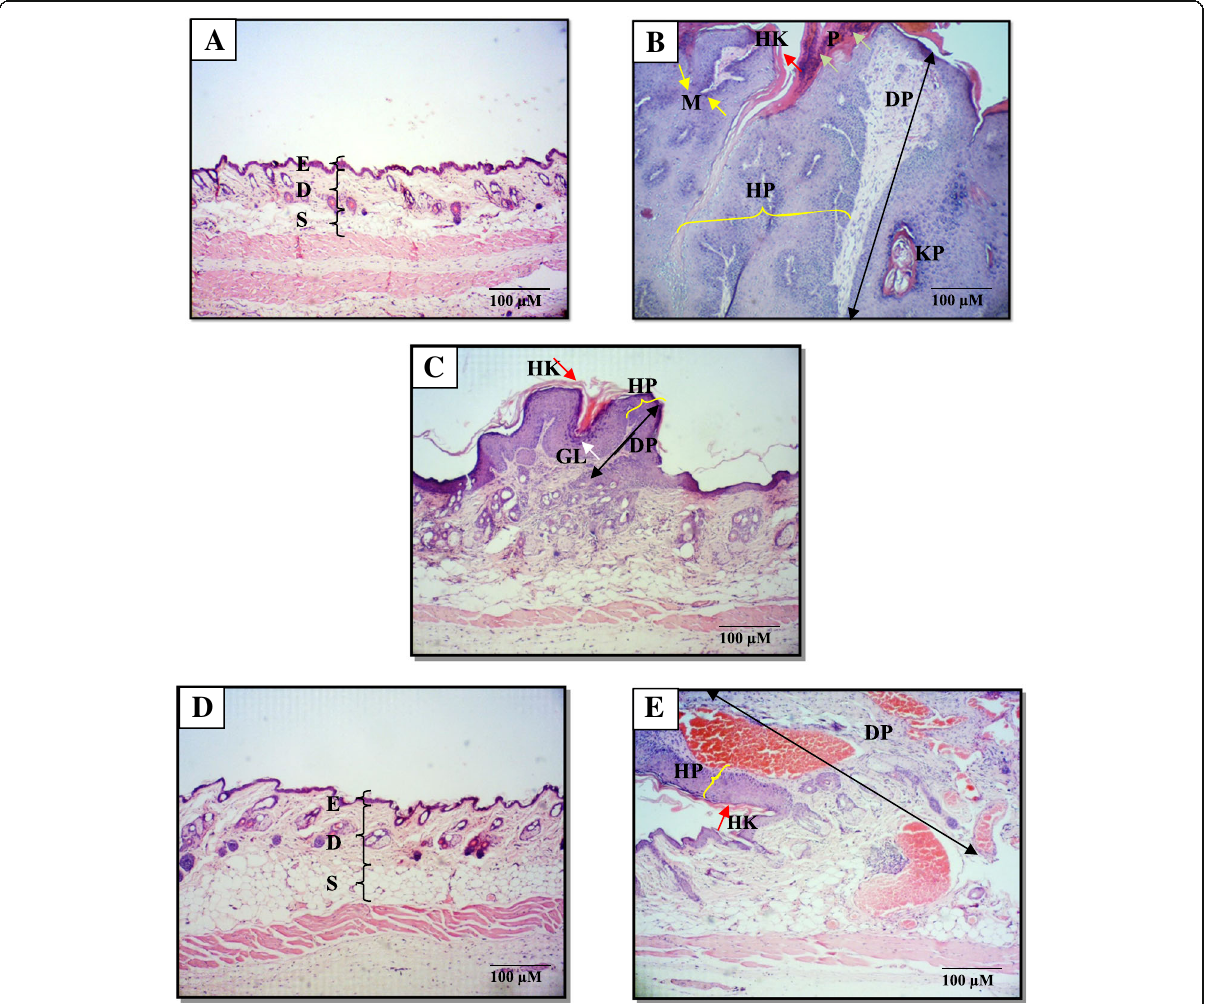
Fig. 1 Micrographs of H&E skin tissues sections treated with ( a ) acetone (Group I; vehicle control) showed normal skin thickness. ( b ) DMBA/TPA (Group II; carcinogen control) showed huge hyperplastic epidermal layer, with increased number of keratinocyte (hyperkeratosis) and parakeratosis, increased size with huge extension of the dermal papillae, presence of keratin pearls and mark mitotic activity. ( c ) 85 nM annonacin (Group III; treatment) showed mild hyperplastic epidermal layer, mild dermal papillae extension, mild hyperkeratosis and prominent granular layer. ( d ) 85 nM annonacin without DMBA/TPA induction (Group IV; treatment control) showed the closest resemblance of skin thickness and morphology to Group 1. ( e ) 10 mg/kg curcumin (Group V; reference) showed moderate hyperplastic epidermal layer with increased number of keratinocyte, increased size with huge extension of dermal papillae. Note: [hyperplastic epidermal layer (HP) marked with yellow curly bracket], [hyperkeratosis (HK) marked with red arrow], [parakeratosis (P) marked with green arrow], [dermal papillae (DP) marked with black double arrow, keratin pearl (KP), [mitotic activity (M) marked with yellow arrow], [granular layer (GL) marked with white arrow], epidermis ( e ), dermis ( d ) and subcutaneous